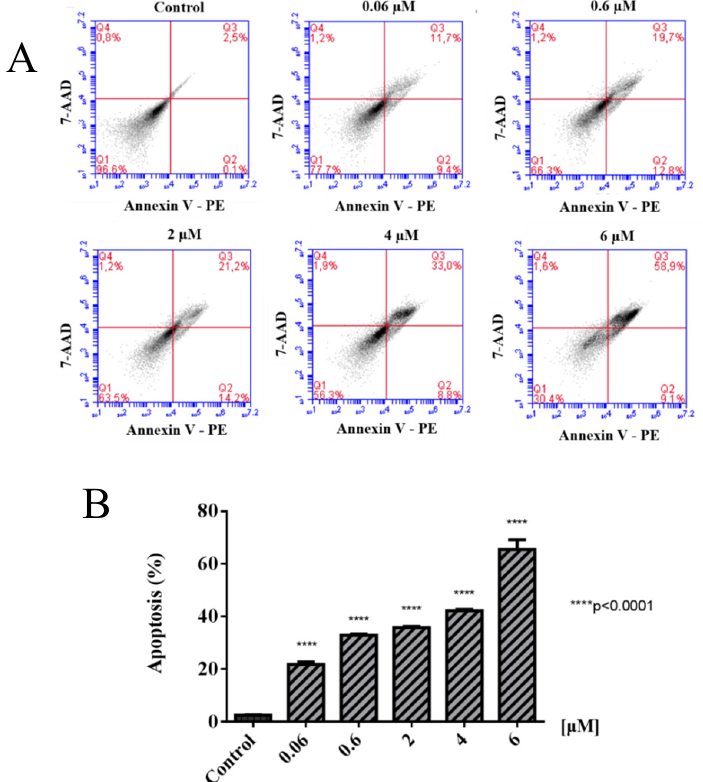
Figure 5. Effect of compound 3 on apoptosis in MDA-MB-231 tumor cells. Camptothecin was used as a positive control for apoptosis. ( A ) Cytometry analysis, the fluorescence of 7AAD is detected in the FL3-A channel and the fluorescence of PE Annexin V is detected in the FL2-A channel. ( B ) Bar chart showing percentages of apoptotic cells.